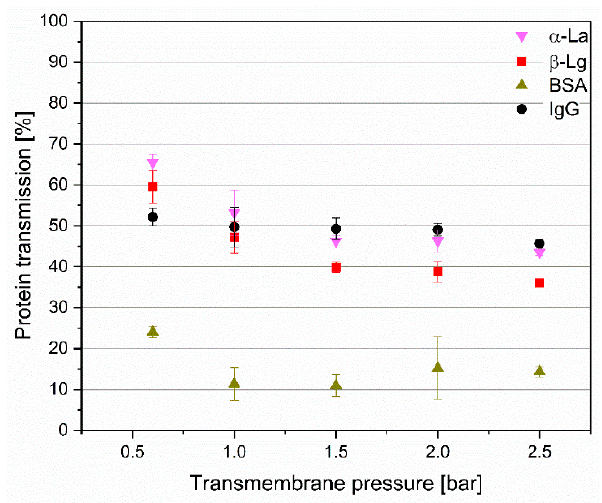
Figure 5. Protein transmission of IgG, α -La, β -Lg, and blood serum albumin (BSA) as a function of the transmembrane pressure at a pore size of 0.14 µm (gradient membrane, 50 °C). Error bars represent standard error of triplets.